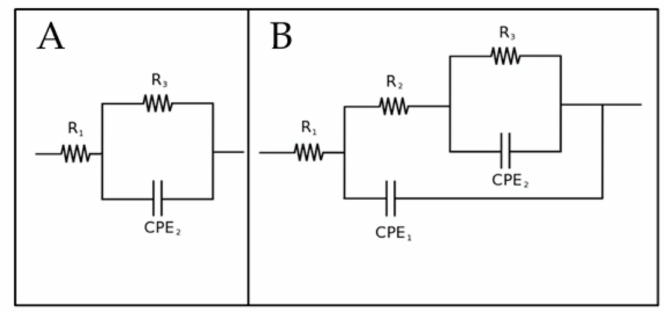
Figure 7. Equivalent circuits employed to fit EIS data for the ZA coated sample, with the circuit that represents the natural oxide film on the surface ( A ) and for the PEO treated samples, with the two circuits that represent the inner and external layers of PEO coating ( B